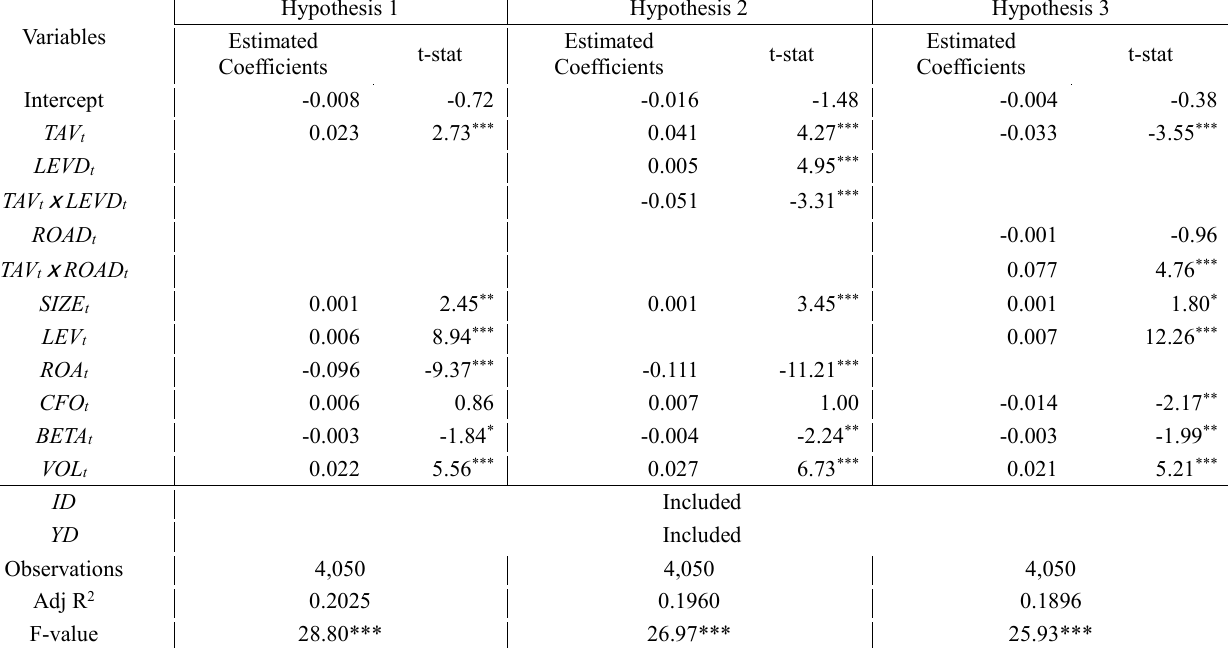
Table 3: Regression results